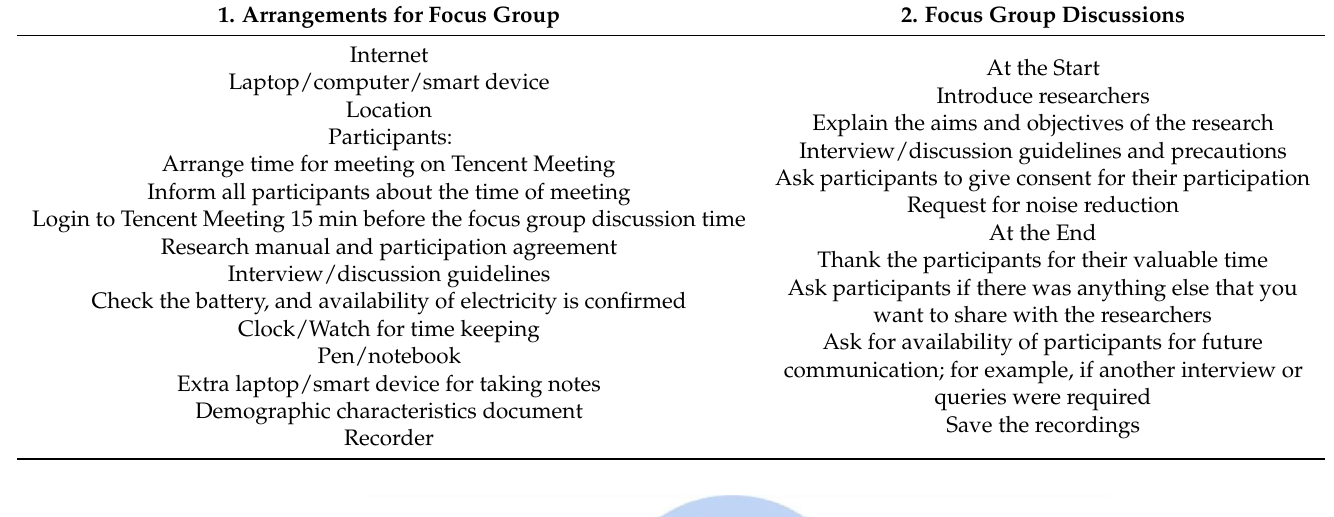
Table 1. Guidelines for focus group discussions.